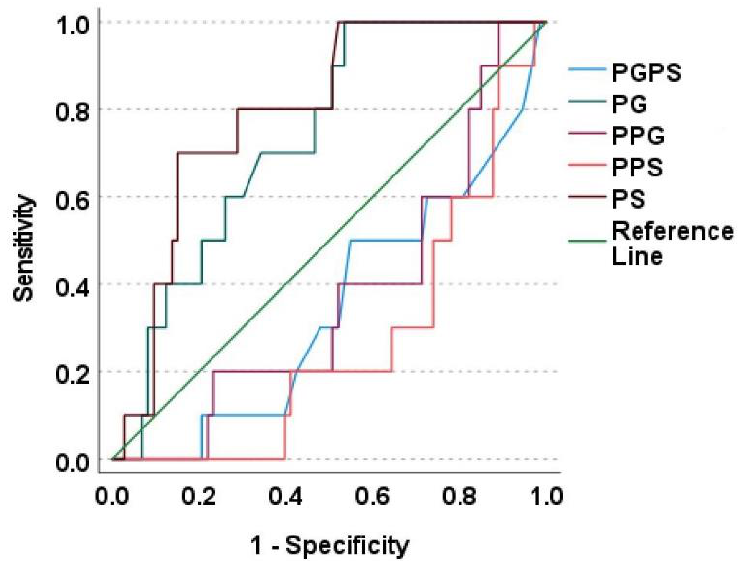
Figure 3. ROC plot for paracetamol metabolites with CYP1A2*6. This is a ROC plot where the diagonal green line indicates the reference line. The brown line above the reference line represents the predictive ability of paracetamol sulphate as like the dark green line that indicates paracetamol glucuronide metabolite. All other metabolite ratios were observed with their lines falling below the reference line thereby they do not significantly predict the SNP. PGPS—Paracetamol glucuronide/Paracetamol sulphate ratio; PG—Paracetamol glucuronide; PPG—Paracetamol/Paracetamol glucuronide ratio; PPS—Paracetamol/Paracetamol sulphate ratio; PS—Paracetamol sulphate.